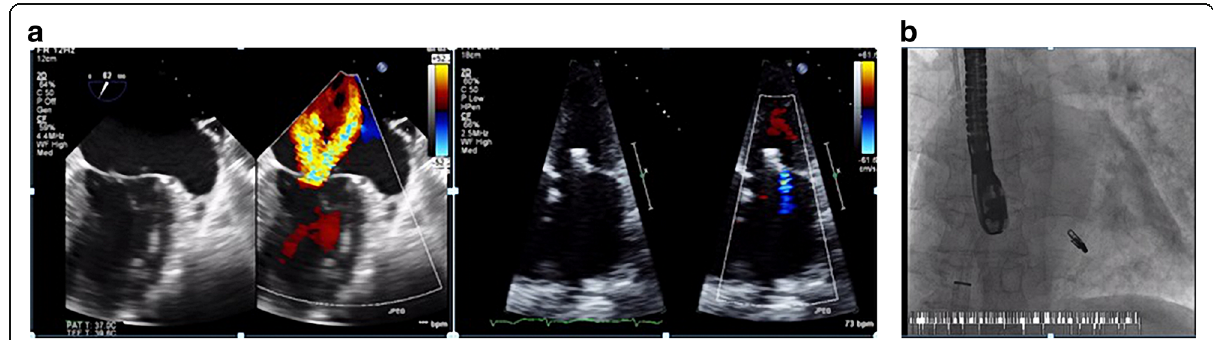
Fig. 3 (Case 2) 69-year-old female patient with functional MR, AF, NYHA class III, and EuroScore 9. a The mitral valve before and after MitraClip deployment. b Intra-procedure image of MitraClip